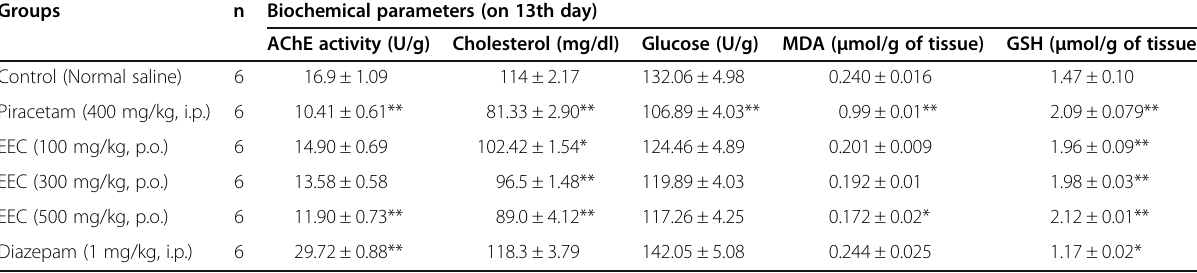
Table 2 Effect of EEC on biochemical parameters administered orally for 12 consecutive days Groups n Biochemical parameters (on 13th